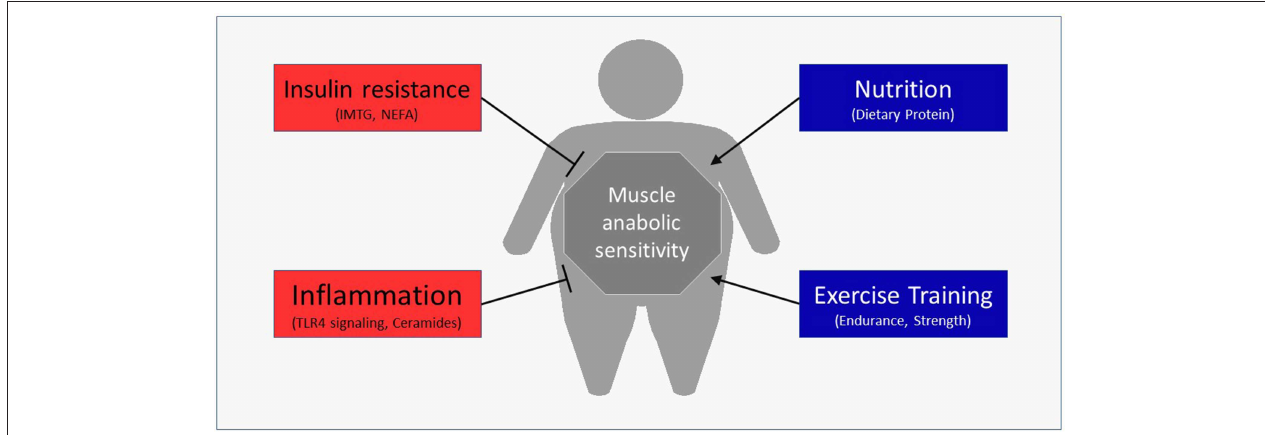
FIGURE 1 | Potential regulators of the postprandial muscle protein synthetic response with